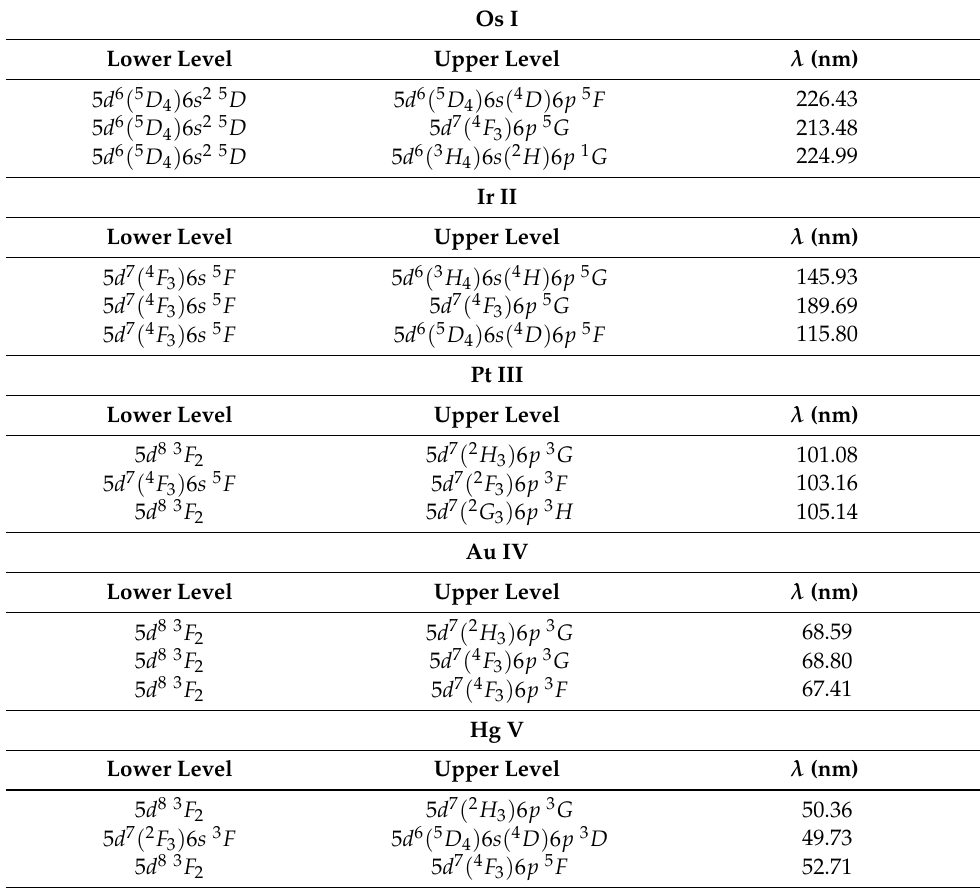
Table 8. Wavelength of the most intense lines from LTE spectra at 5000 K using GRASP2K calculations. Os I Lower Level Upper